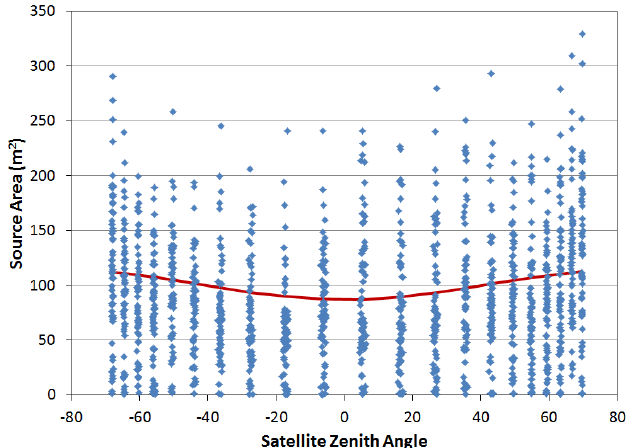
Figure 5. Variation in flare area estimates as a function of satellite zenith angle. The red line is the best fit line based on an elliptical model of the flare shape.